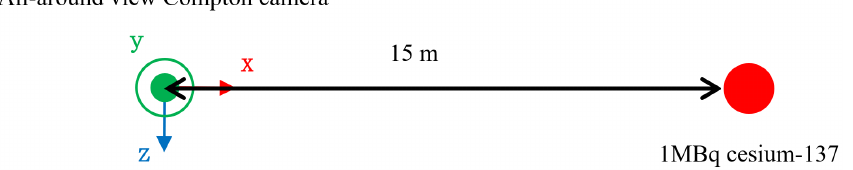
Figure 10. Simulation condition in which one radiation source exists: a single radiation source was positioned 15 m from the mobile robot. Cesium-137 (1 MBq) was adopted as the radiation source. Figure 11a illustrates the simulation result. SP represents the first measurement point where the robot started to move, while EP is the position at which the gamma-ray measurements were completed. The color bar on the right represents the value added to each pixel. The black and red arrows represent the directions of the first and second principal components, respectively. The ground truth of the position of the radiation source is represented as a red dot. The detector was fixed on the mobile robot; therefore, the detector orientation at position x i was determined along the robot’s movement direction, −−−→ x i − 1 x i . Figure 11b shows the detector orientation during the inspection. The detector i.e., orientation was zero when the X axis was facing upward, and clockwise rotation was defined as positive.